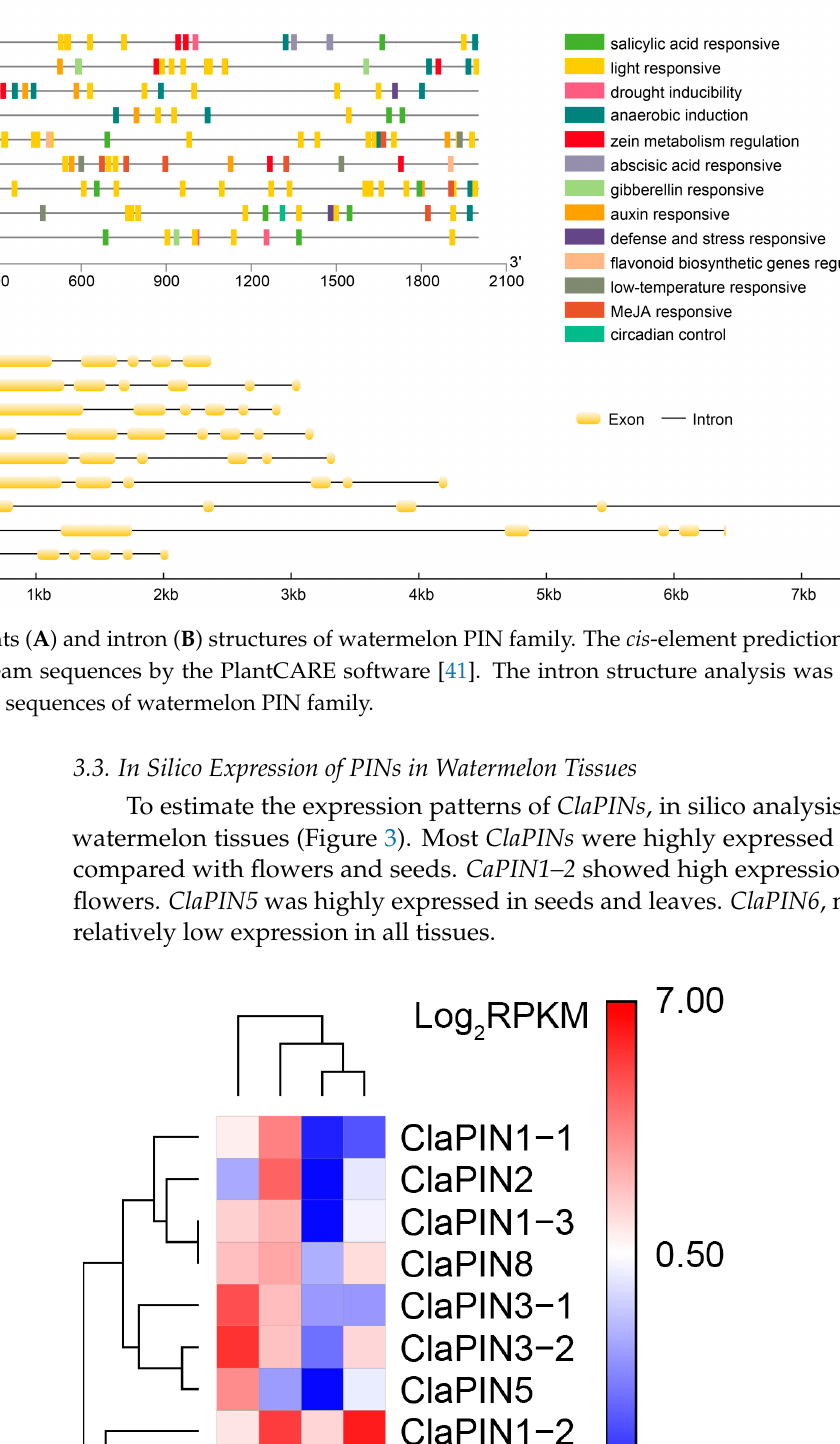
Figure 3. In silico expression of ClaPINs in watermelon tissues. The single capital letters represent root (R), leaf (L), flower (F), and seed (S).